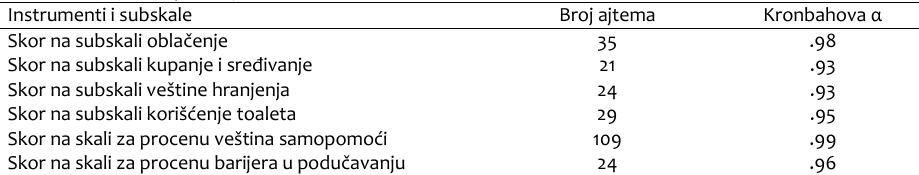
Tabela 2. Pouzdanost primenjenih skala i